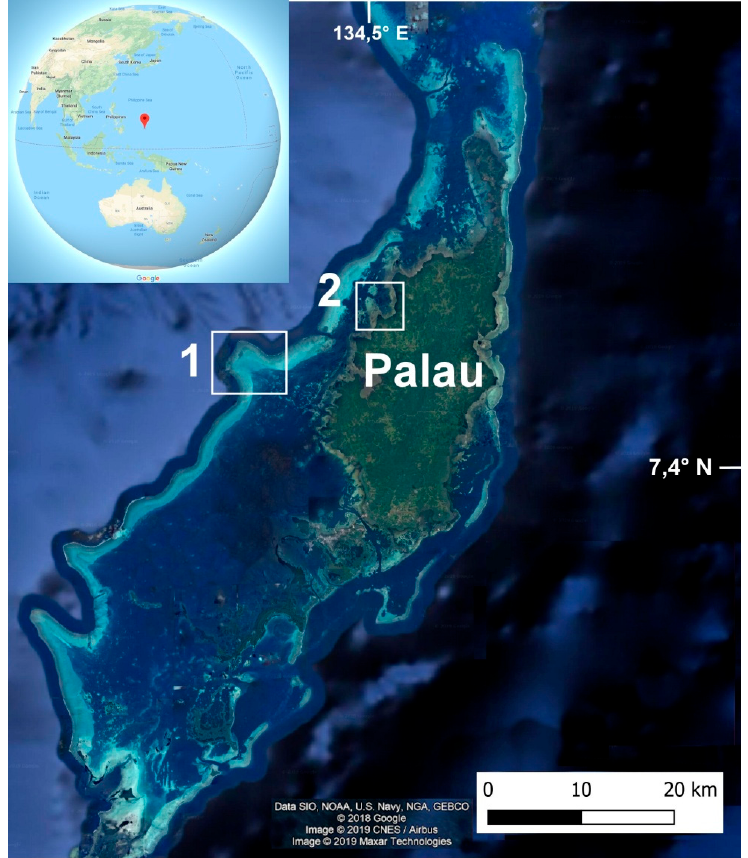
Figure 1. The main island of the Palau Republic (Micronesia—West Pacific). Numbers indicate the barrier reef zone (site no. 1) and coastal reef zone (site no. 2) where the shallow-water benthic habitat mapping was performed (basemap and inset Google © 2019).